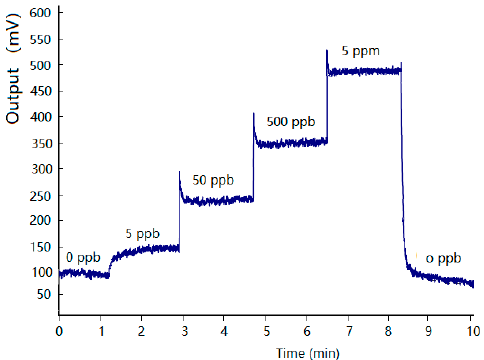
Figure 5. Response of the fabricated sensor to benzene at different concentrations.